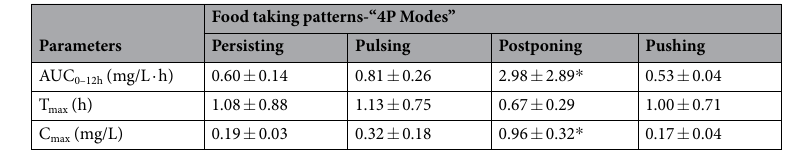
Table 2. Pharmacokinetic parameters of valsartan capsules in beagles catalogued into four types in fed state of 80 mg valsartan per beagle. Data were reported as mean ± SD. Comparison between groups was done by t-test. * p < 0.05, “Postponing” group was compared as the reference with other three